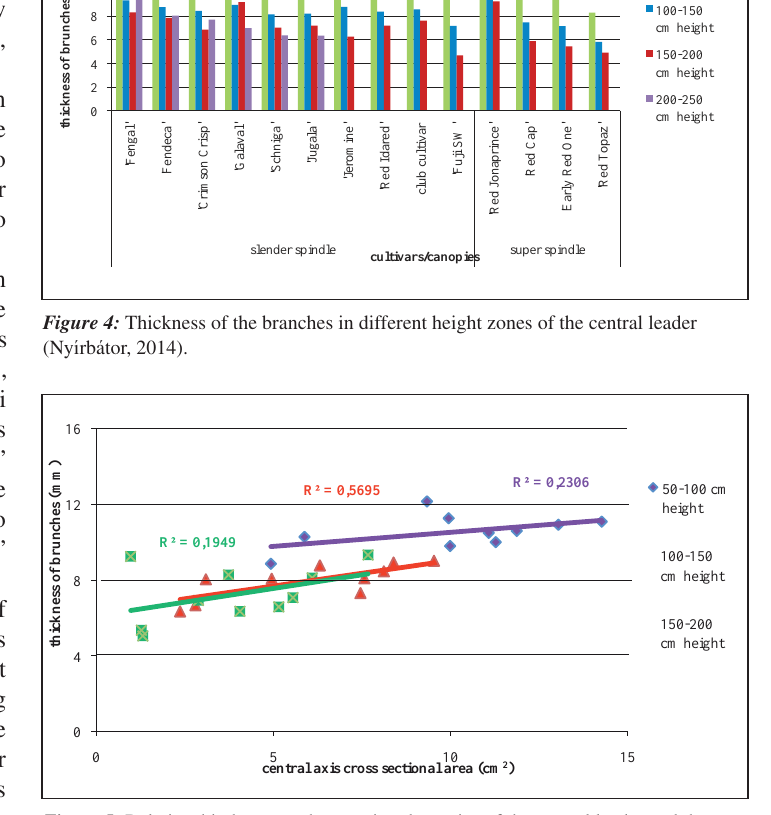
Figure 5: Relationship between the tapering dynamics of the central leader and the thickness of the main branches in slender spindle canopy (Nyírbátor,